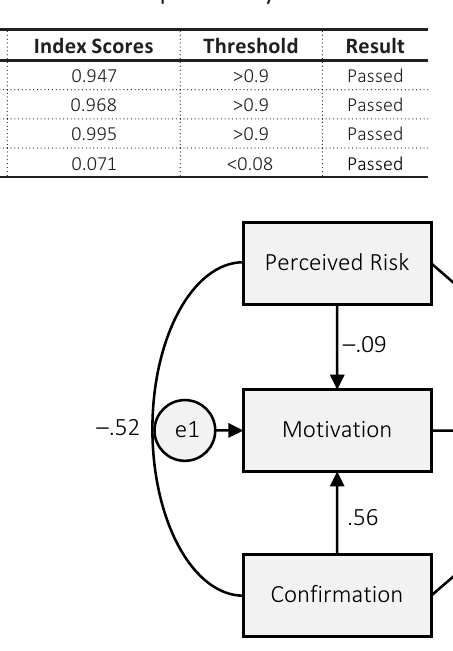
Figure 2. Path analysis